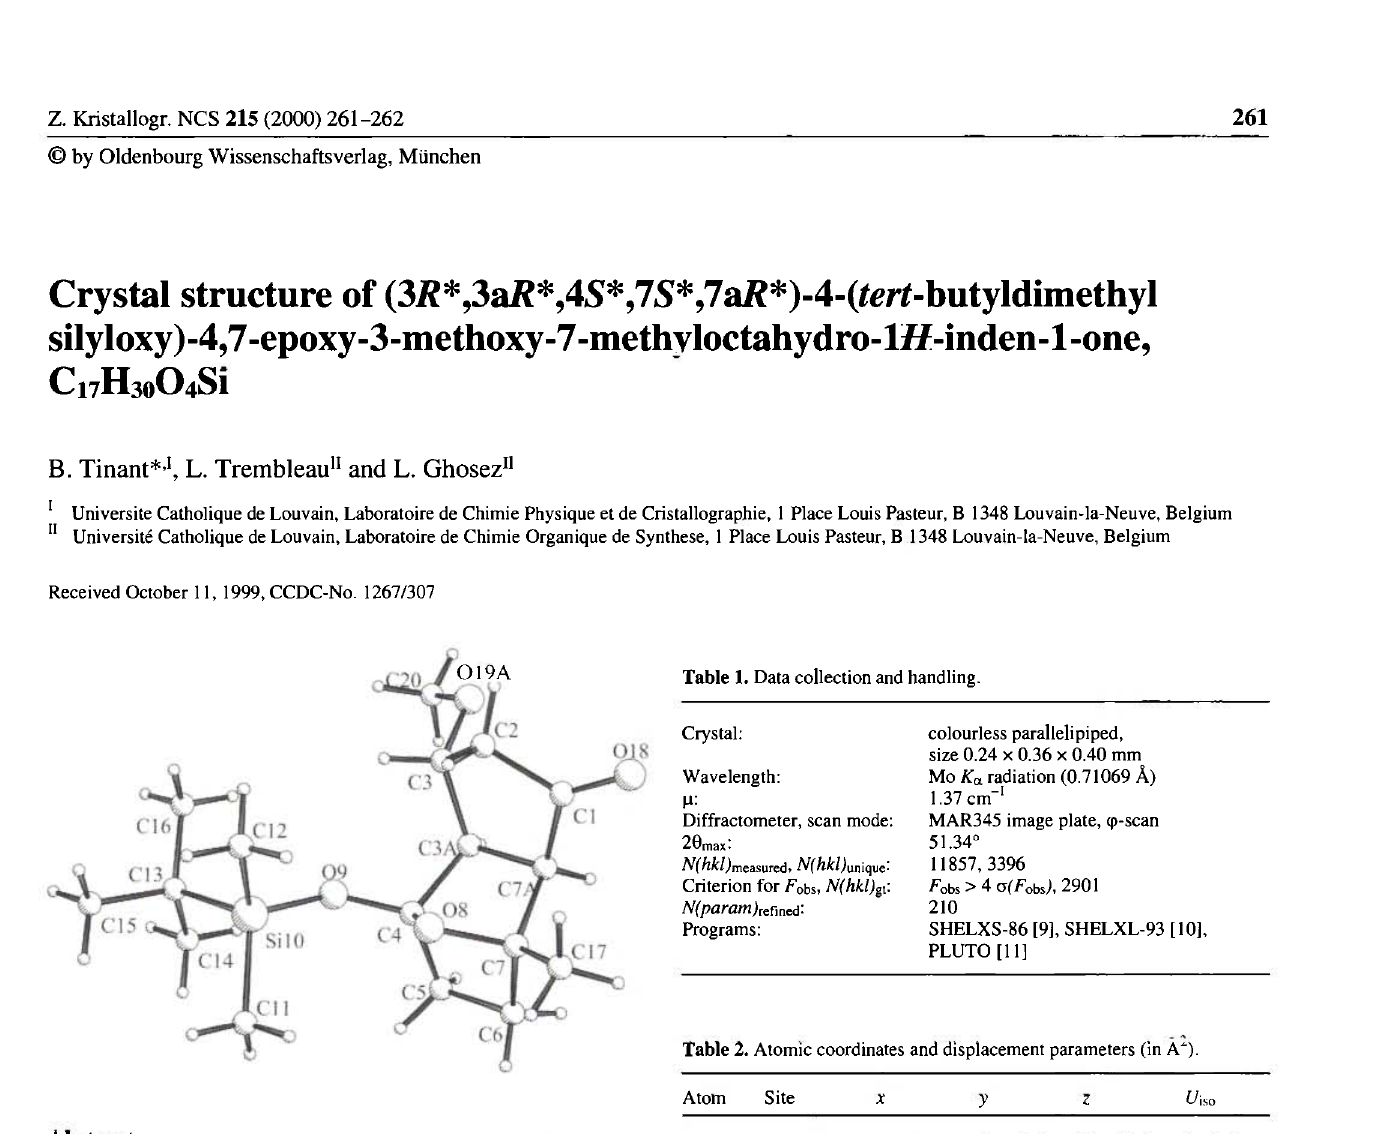
Table 2. Atomic coordinates and displacement parameters (in A